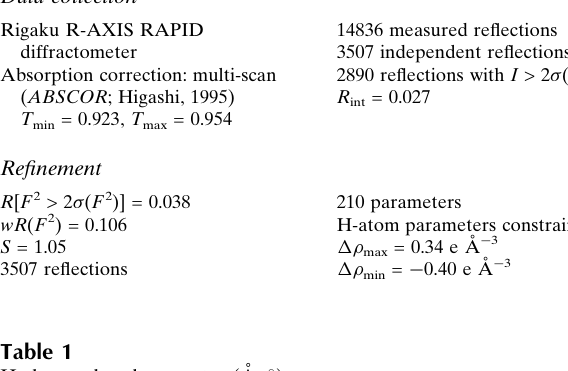
Hydrogen-bond geometry (A˚ , (cid:2)